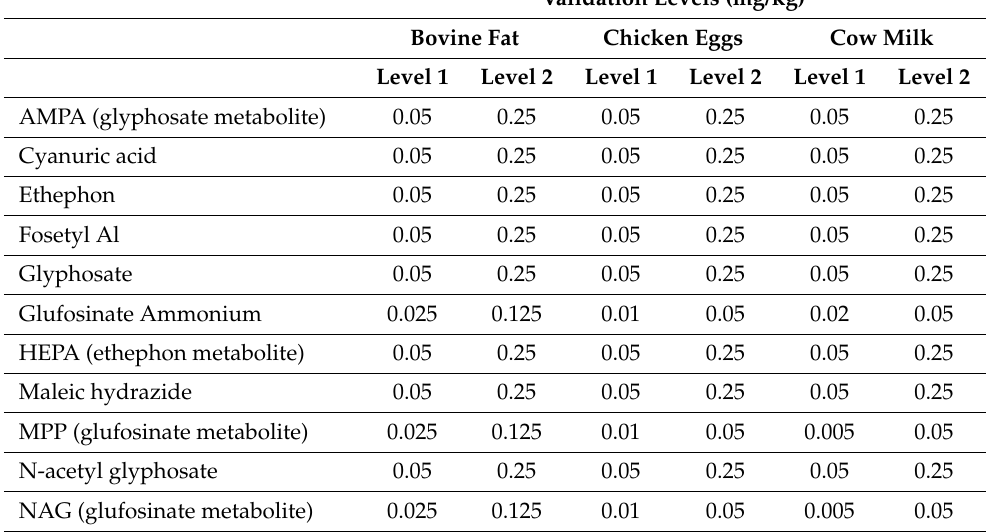
Table 2. Validation levels for all pesticides in each matrix. Level 1 = LOQ, Level 2 = 5 × LOQ for all pesticides in all matrices except 2.5 × LOQ for glufosinate ammonium and 10 × LOQ for MPP and NAG in cow’s